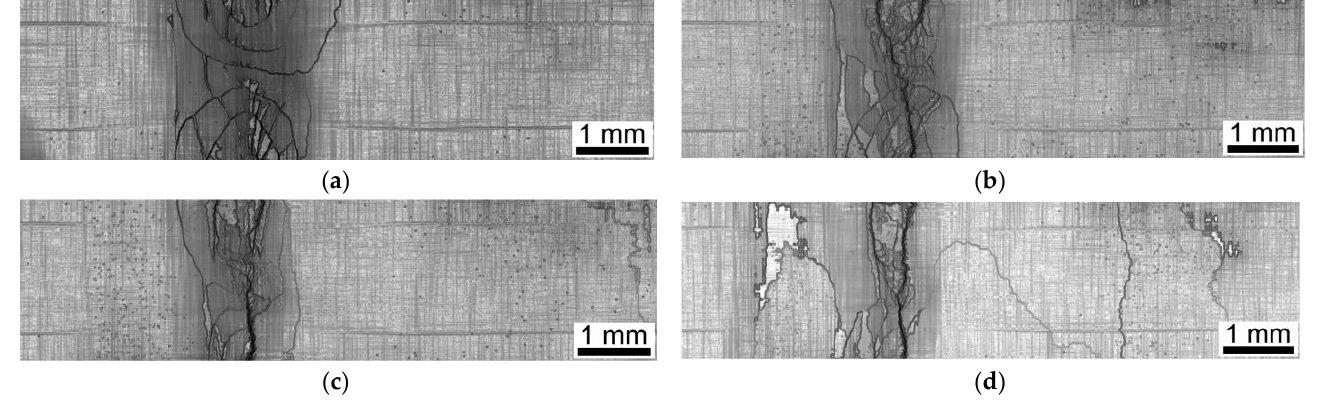
Figure 12. The evolution of deformation structures at the stage of crack propagation (third stage): ( a ) ε = 0.156, ∆ ε = 0.008; ( b ) ε = 0.168, ∆ ε = 0.012; ( c ) ε = 0.188, ∆ ε = 0.008; ( d ) ε = 0.196, ∆ ε = 0.008. All pseudo-images on ( a – d ) are obtained at T =